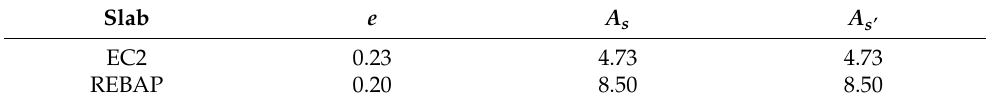
Table 6. Slab dimension for first case of study ( e , As , As’ values in m and cm 2 /m). Slab